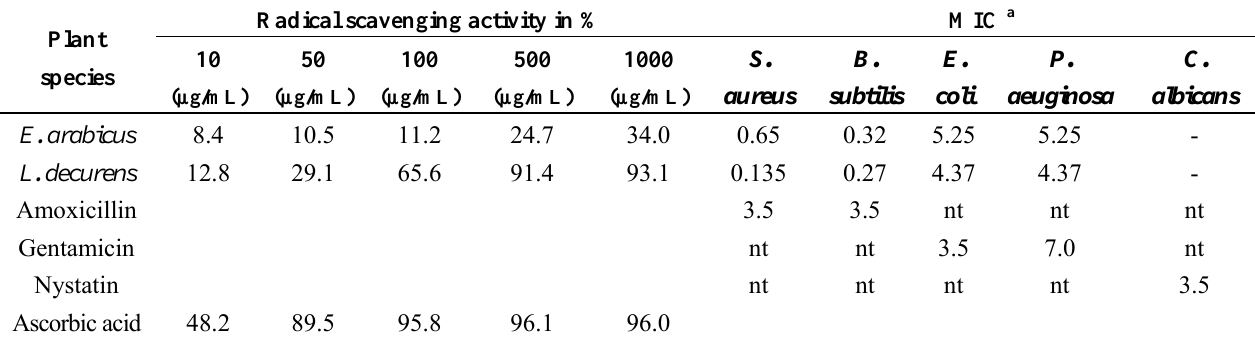
a : minimum inhibitory concentration values are given as mg/mL for essential oils and μ g/mL for standard antibiotics, nt: not